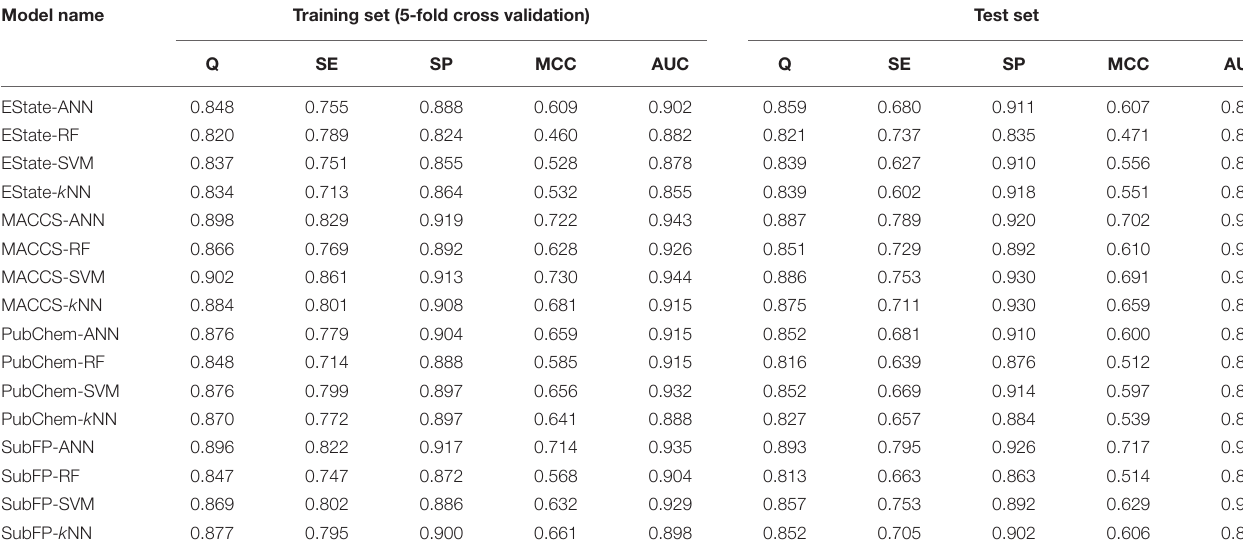
TABLE 1 | Performance of 16 single classifiers using four sets of fingerprints and four modeling methods on 5-fold cross validation and test set. Model name Training set (5-fold cross